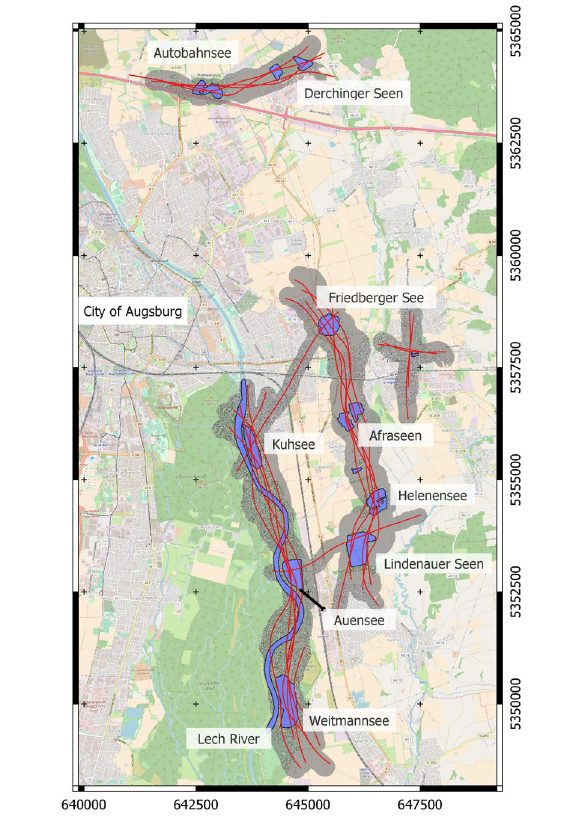
Figure 4. Study area Augsburg; OpenStreetMap superimposed with shaded LiDAR DSM relief map, captured water lakes (blue polygons), and flight trajectories (red); coordinate frame: